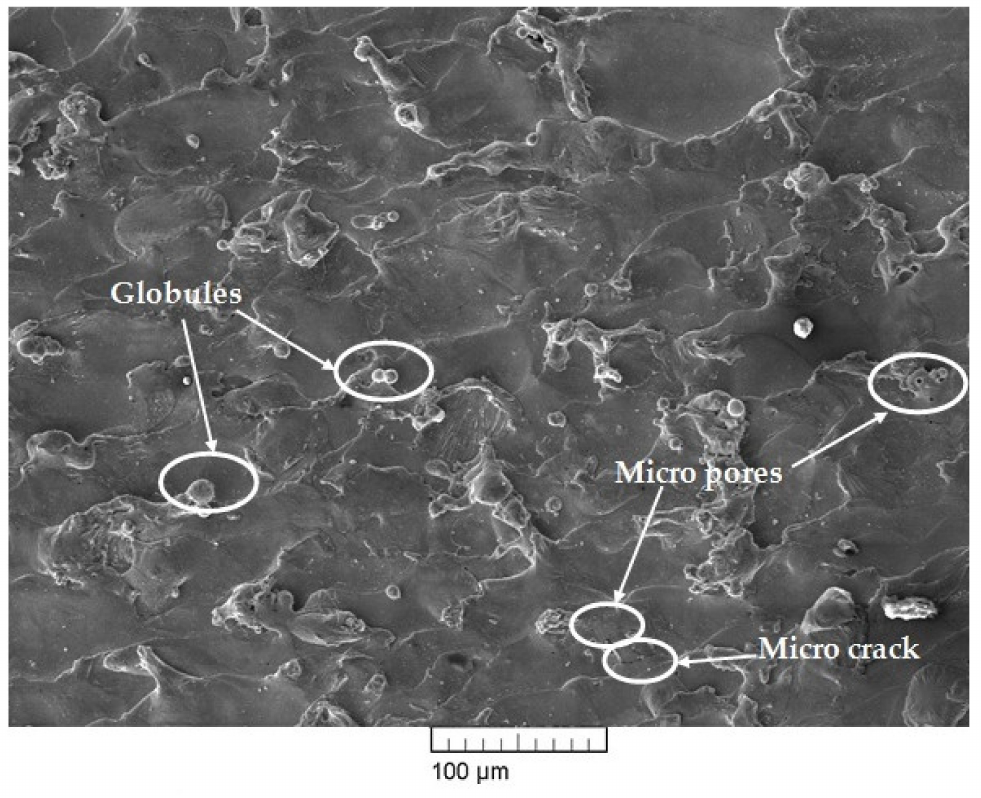
Figure 8. SEM micrograph of machined surface at optimized